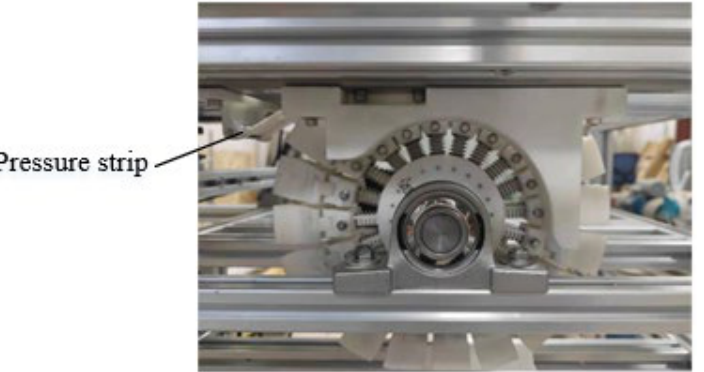
Figure 17. Shrimp clamping test bench.